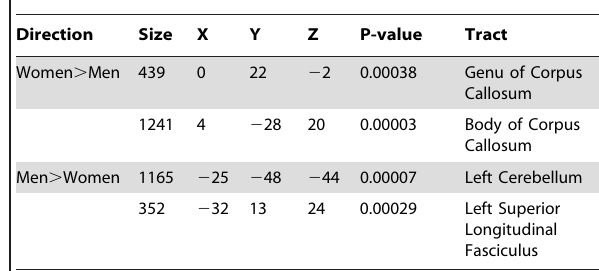
Table 2. Areas of FA